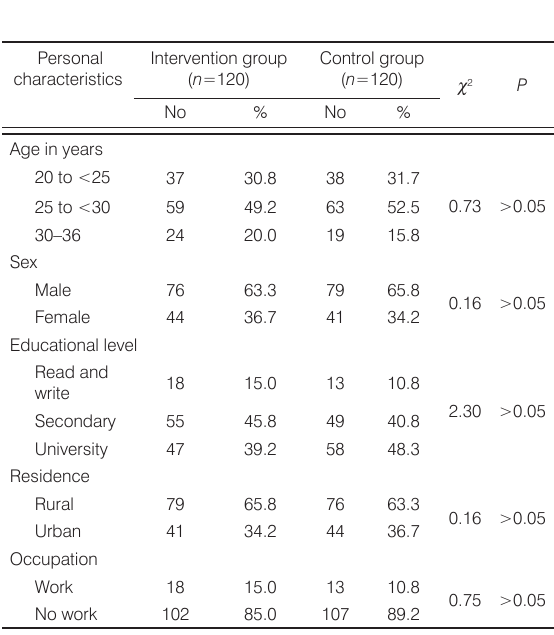
Table 1. Personal characteristics of the studied participants.